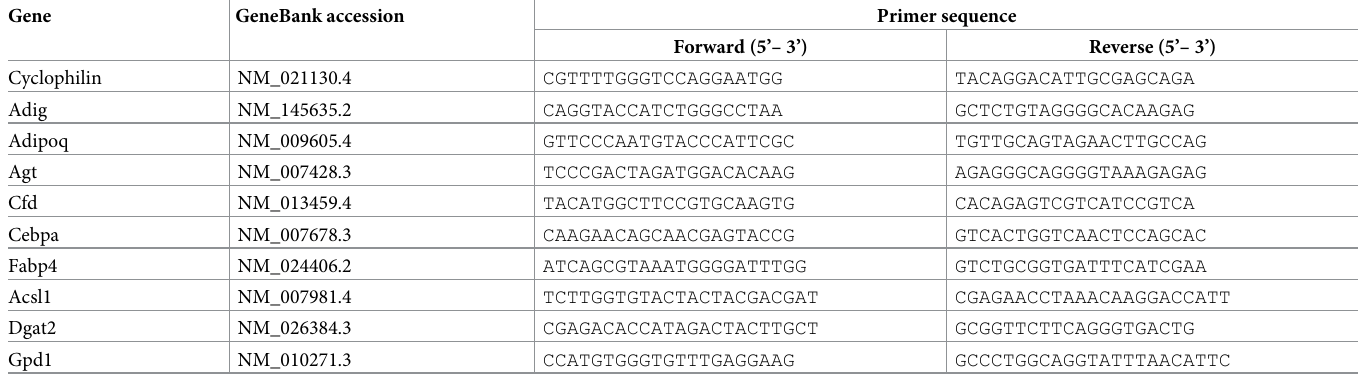
Table 1. Sequences of primers used for real-time quantitative